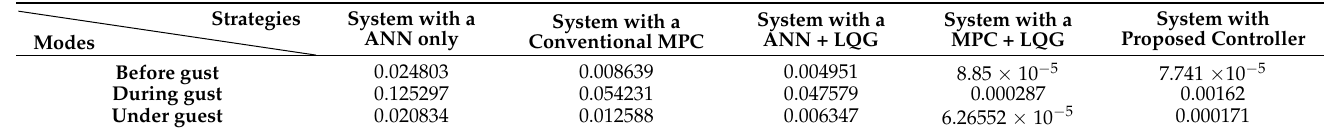
Table 3. Max overshoot percentage of generated voltages deviation at different operating modes and different control